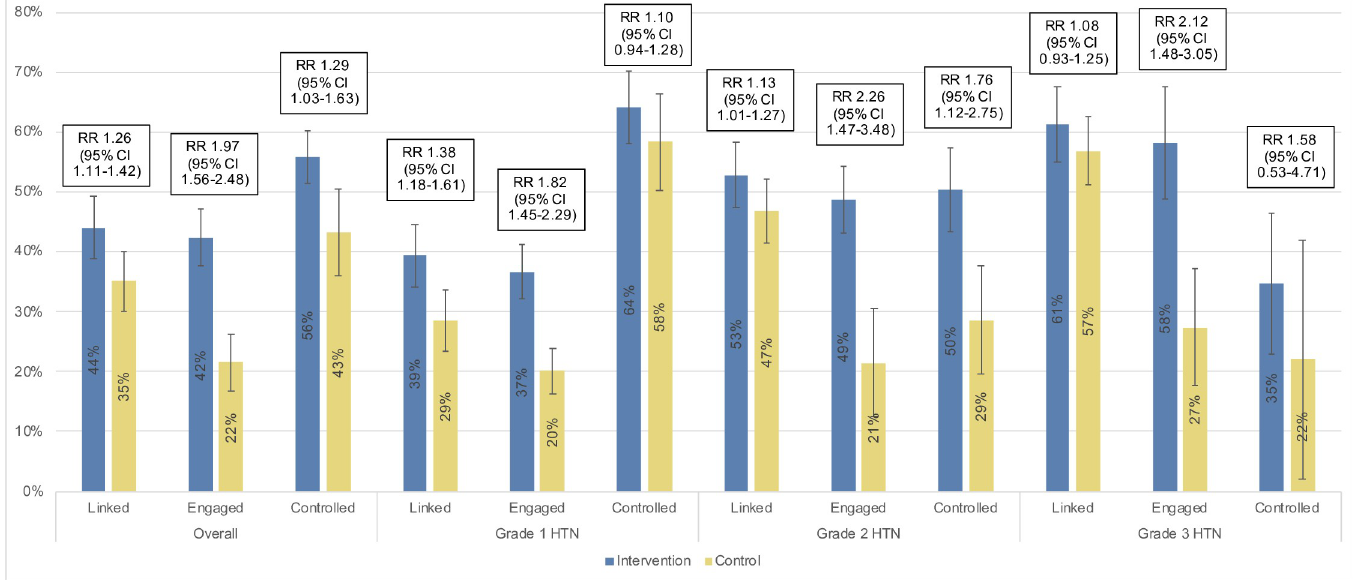
Fig 5. Cascade of hypertension care in 20 communities in Uganda. Figure represents the proportion attaining each cascade step, among those attaining the prior step. Estimates obtained using 2-stage TMLE to estimate and compare the community-level proportion attaining each cascade step. Vertical error bars depict arm-specific 95% CIs. Linkage to care defined as � 1 visit for hypertension care in the first year after baseline hypertension screening. Engagement in care defined as � 1 clinic visit for hypertension care in each of 3 years of study follow-up. Hypertension control defined as the lowest of 3 BP measurements < 140/90 mm Hg at year 3 community-wide hypertension testing. Baseline hypertension severity defined by lowest of 3 baseline BP measurements and classified as Grade 1 (BP 140–159/90–99 mm Hg), Grade 2 (BP 160–179/100–109 mm Hg), and Grade 3 (BP � 180/110 mm Hg). BP, blood pressure; CI confidence interval; HTN, hypertension; RR, relative risk; TMLE, targeted maximum likelihood